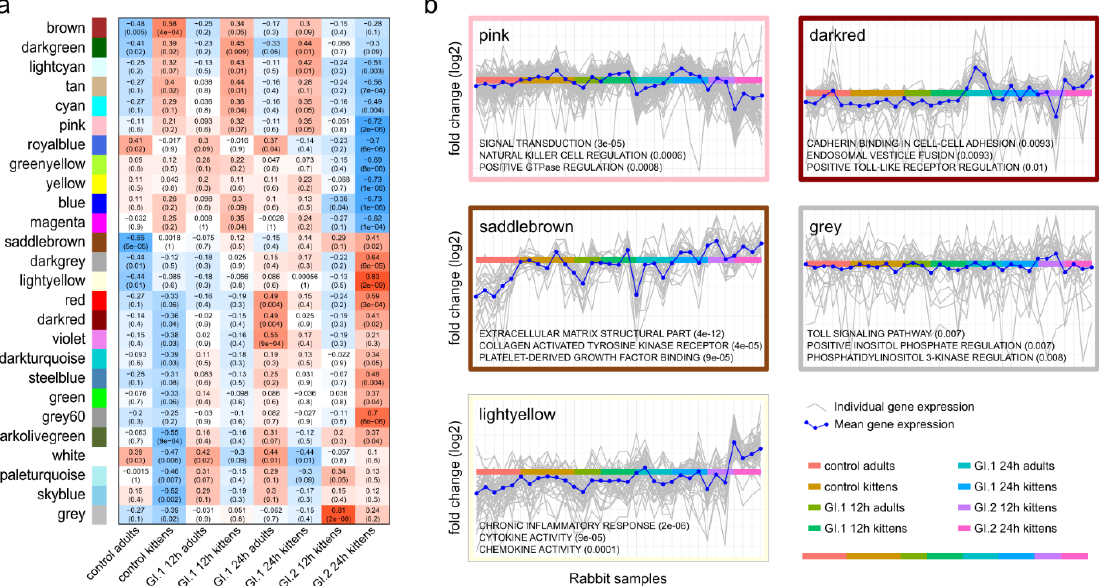
Figure 2. Correlation between gene co-expression modules and the rabbit treatments ( a ) and functional enrichment of select modules ( b ). The pink co-expression module contained genes that tended to be downregulated in control adults, upregulated in control kittens, further upregulated in GI.1-infected kittens, but markedly downregulated in GI.2-infected kittens. Many of the other modules were significantly correlated with the large expression changes in GI.2-infected kittens. In ( a ), the correlation coefficient is given, and the p-value is in brackets. In ( b ), significantly enriched gene ontology terms are given with the p-value in brackets.